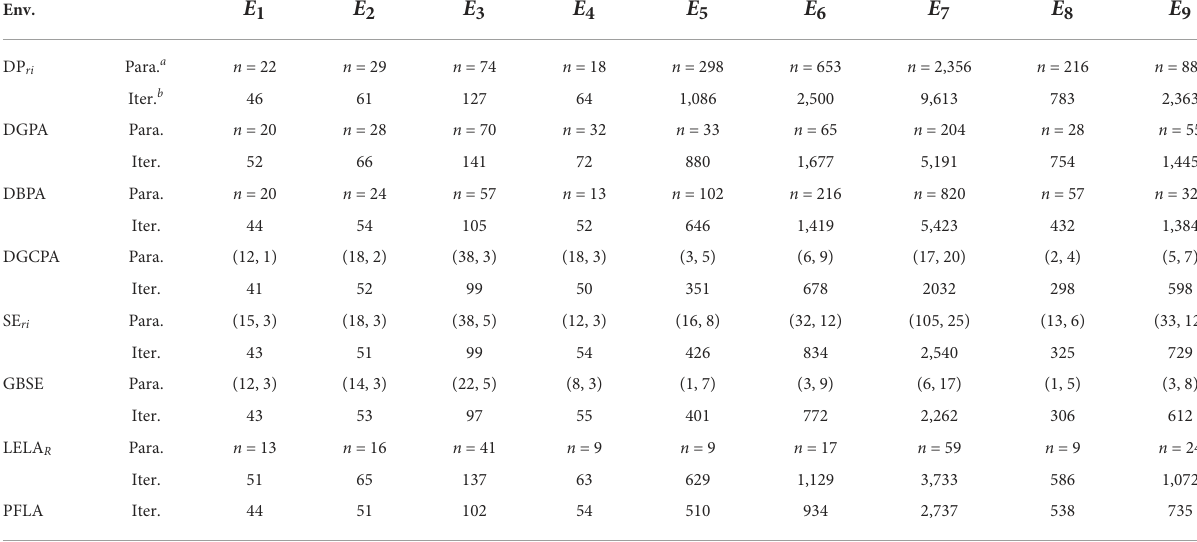
TABLE 3 Comparison of the average number of iterations required for convergence of the compared algorithms in environments E 1 to E 9 . Env. DP